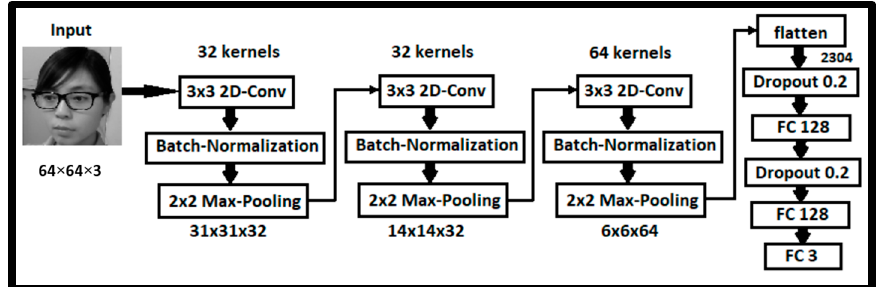
Figure 11. Proposed S ‐ CNN architecture.